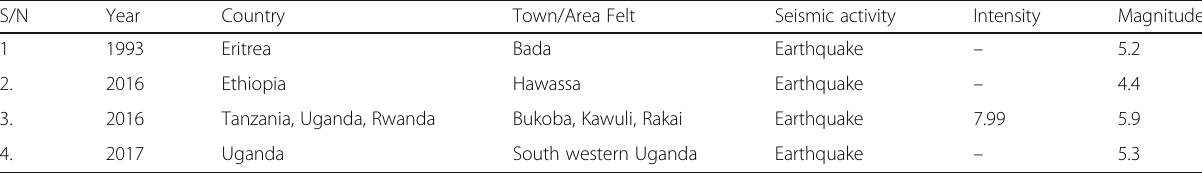
Table 4 Seismic occurrences, location, year, magnitude and intensity in East Africa S/N